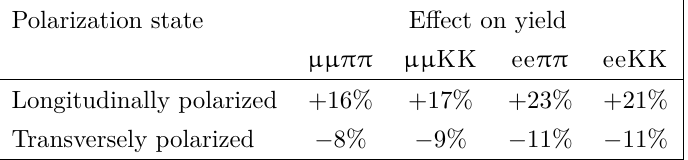
Table 1 . The effect on the signal yields of reweighting to the extreme polarization scenarios, described in more detail in the text, relative to the scenario with isotropic decays. The change in the fraction of signal events that pass the selection criteria affects the final results of the